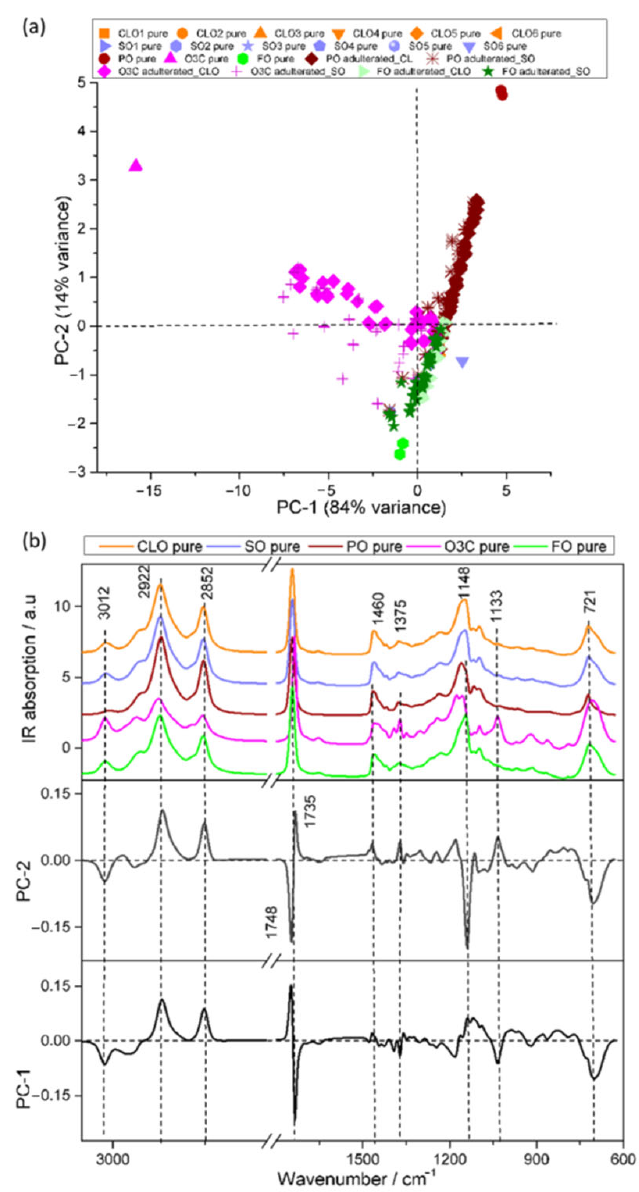
Figure 3. PCA scores and loadings of the IR spectra collected from the CLO and SO samples adulterated with PO, O3C, and FO. ( a ) PC1 (84% explained variance) versus PC2 (14% explained variance) scores plot, and ( b ) representative IR spectra and the associated loadings for PCs 1 and 2.